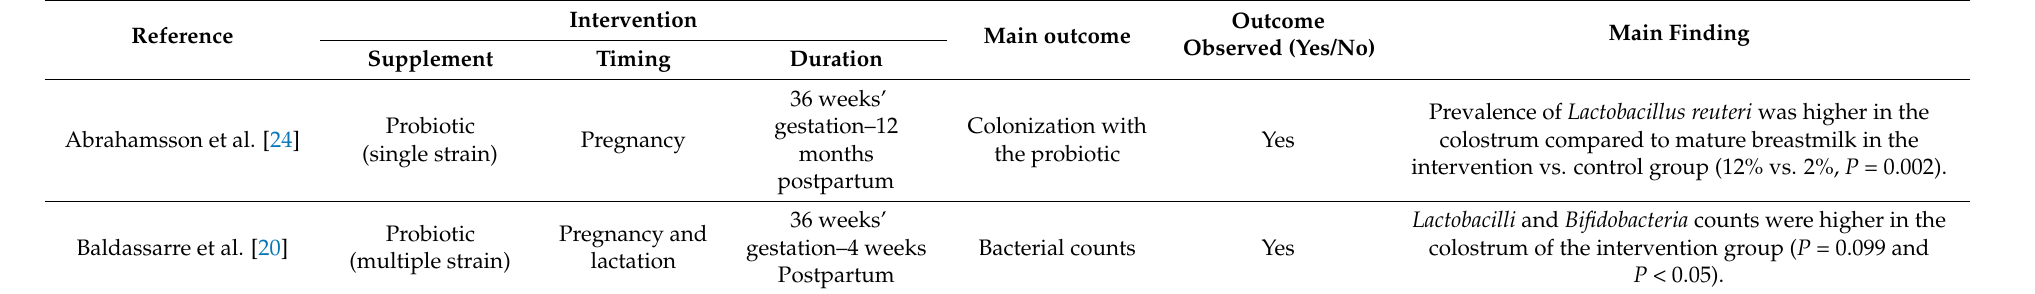
Table 3. Summary of results of the effects of maternal nutritional supplementation on the breastmilk